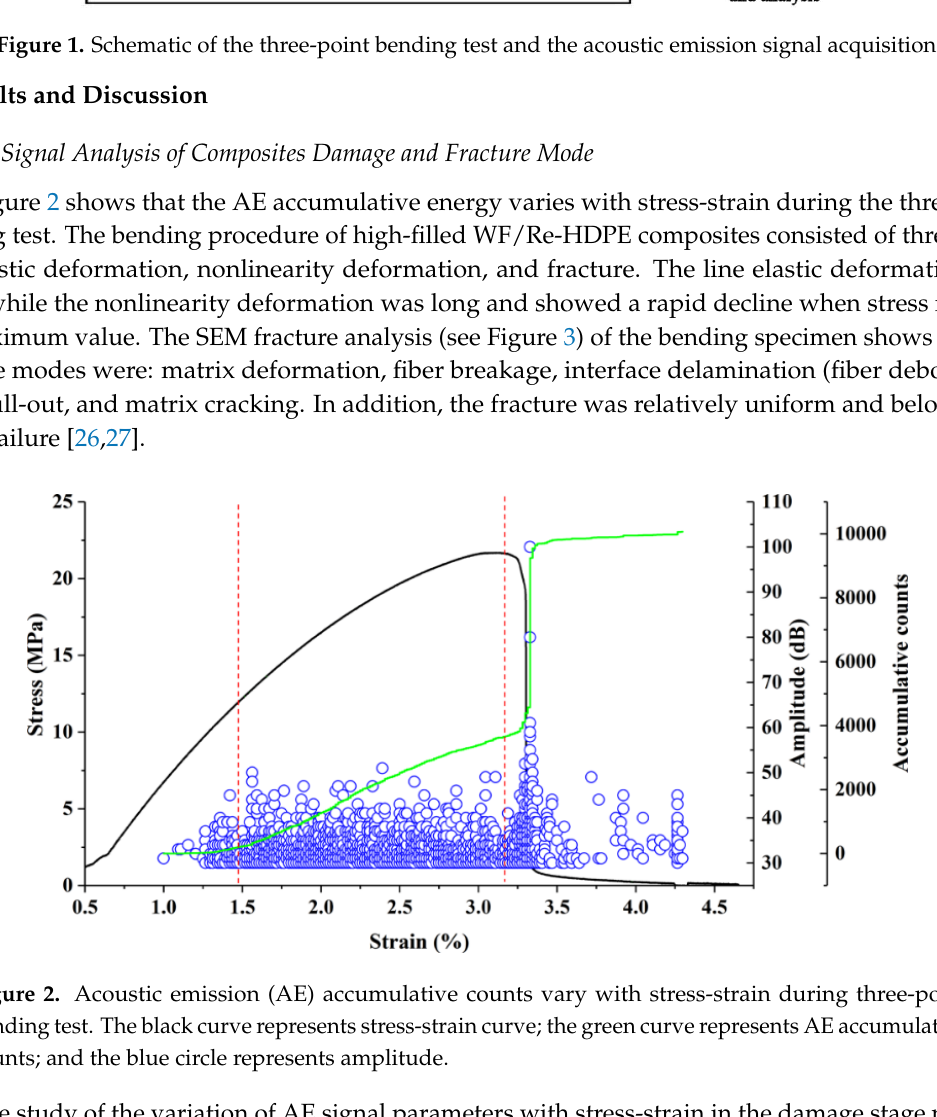
Figure 1. Schematic of the three-point bending test and the acoustic emission signal acquisition.